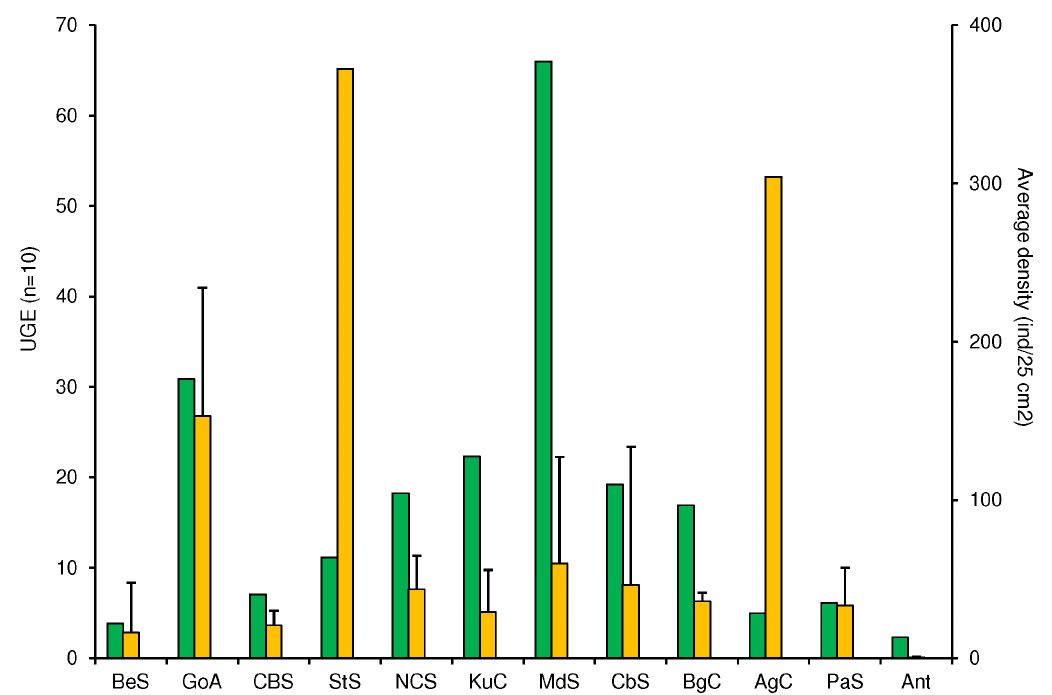
Figure 4. Comparison of the estimated species richness (UGE, n=10) and average density (ind/0.0625 m 2 =ind/quadrat of 25 6 25 cm 2 ) among the LMEs. Yellow bars indicate average density values and green bars represent standardized (UGE) number of species. LME